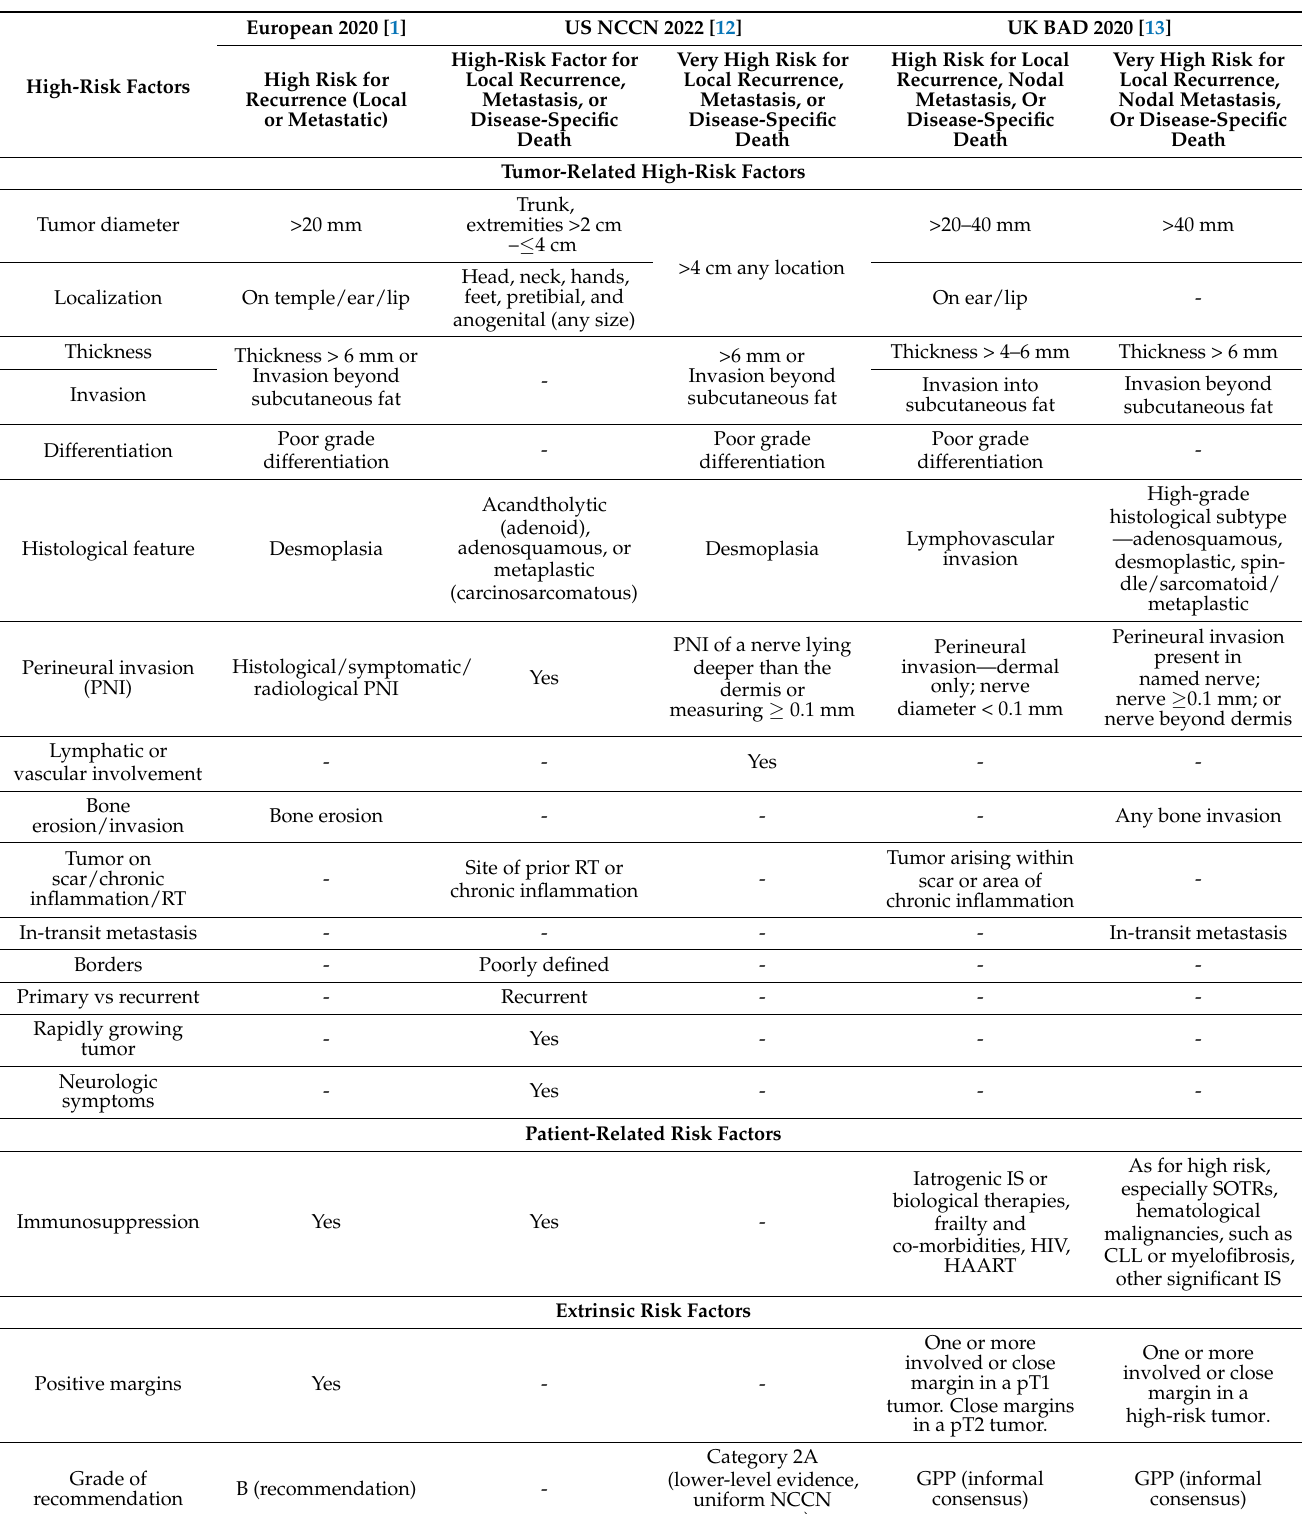
Table 1. Risk factors for high-risk cSCC in current guidelines are summarized. The presence of any high-risk factor places the patient in the high-risk